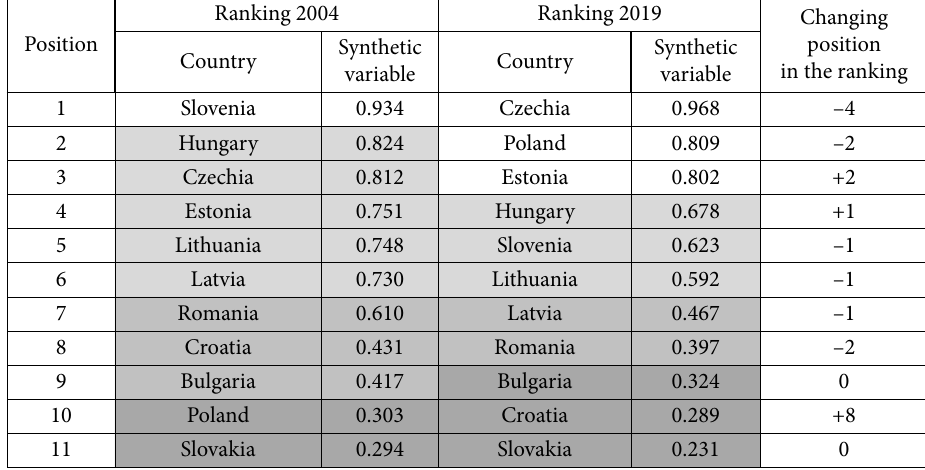
Table 4. Rankings of CEE countries with regard to labour market situation in 2004 and 2019